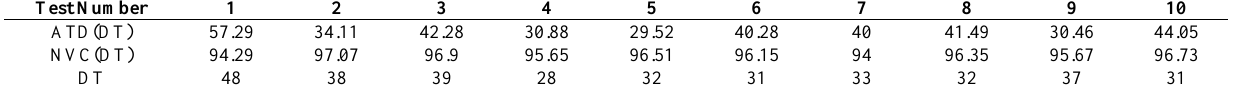
Table 2. Results of ten experiments with scenario 1 (unbounded node degree).